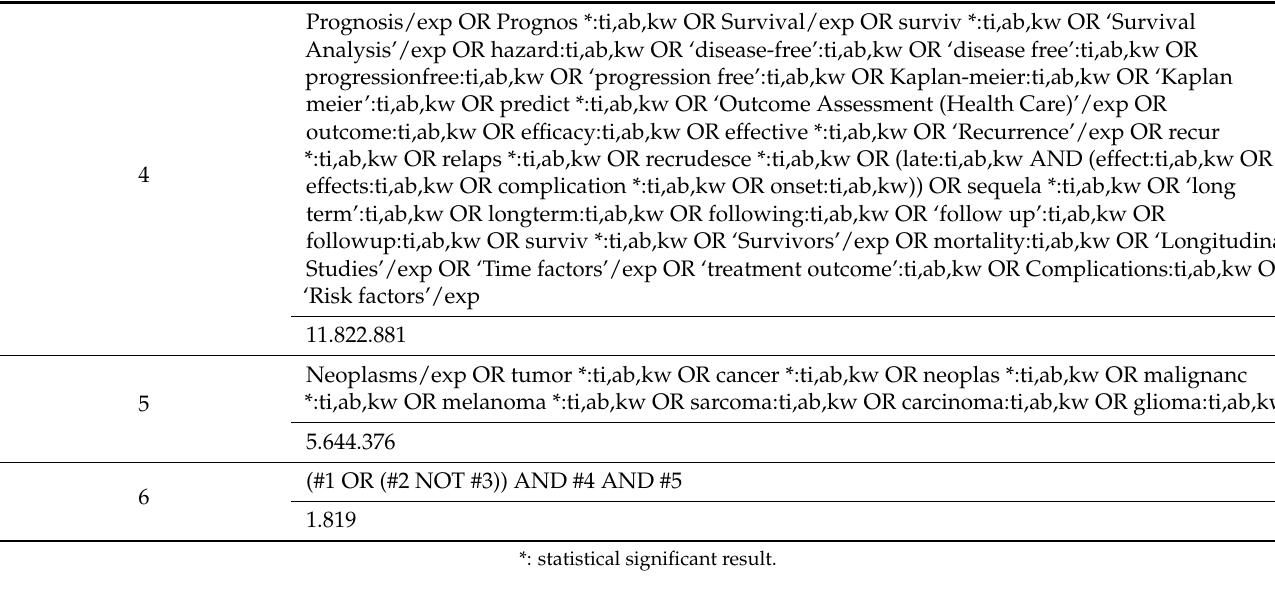
Table A3. Web of Science search